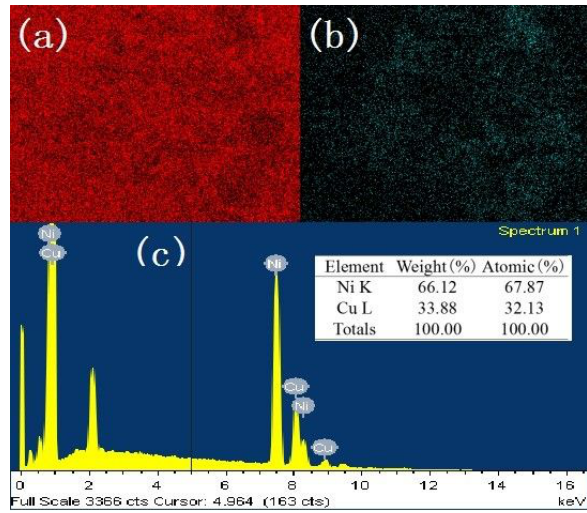
Figure 7: EDS results of the sample with the Ni/Cu value of 2.0.